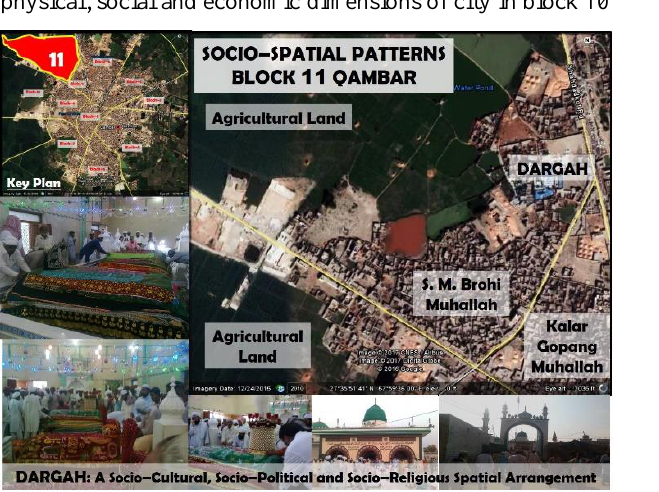
Fig. 15 . Socio spatial analysis of Qambar: Dargah as an element of refuge for citizens in block 11